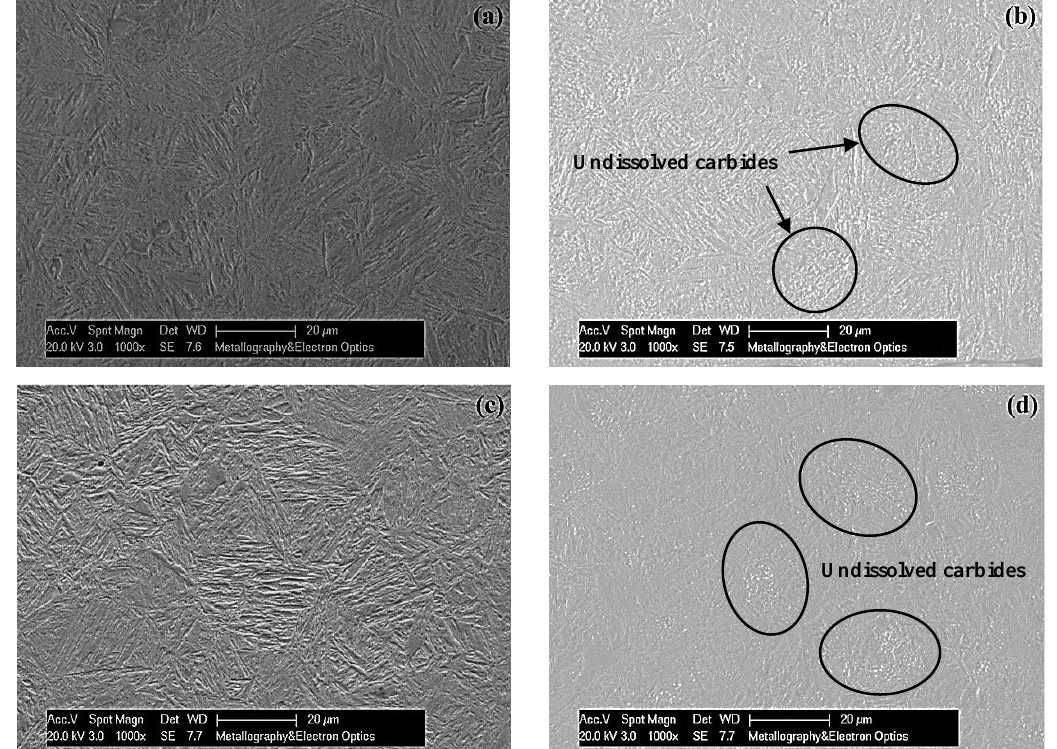
Figure 3. SEM micrographs obtained from ( a ) FP_10, ( b ) SF_10, ( c ) FP_200 and ( d )